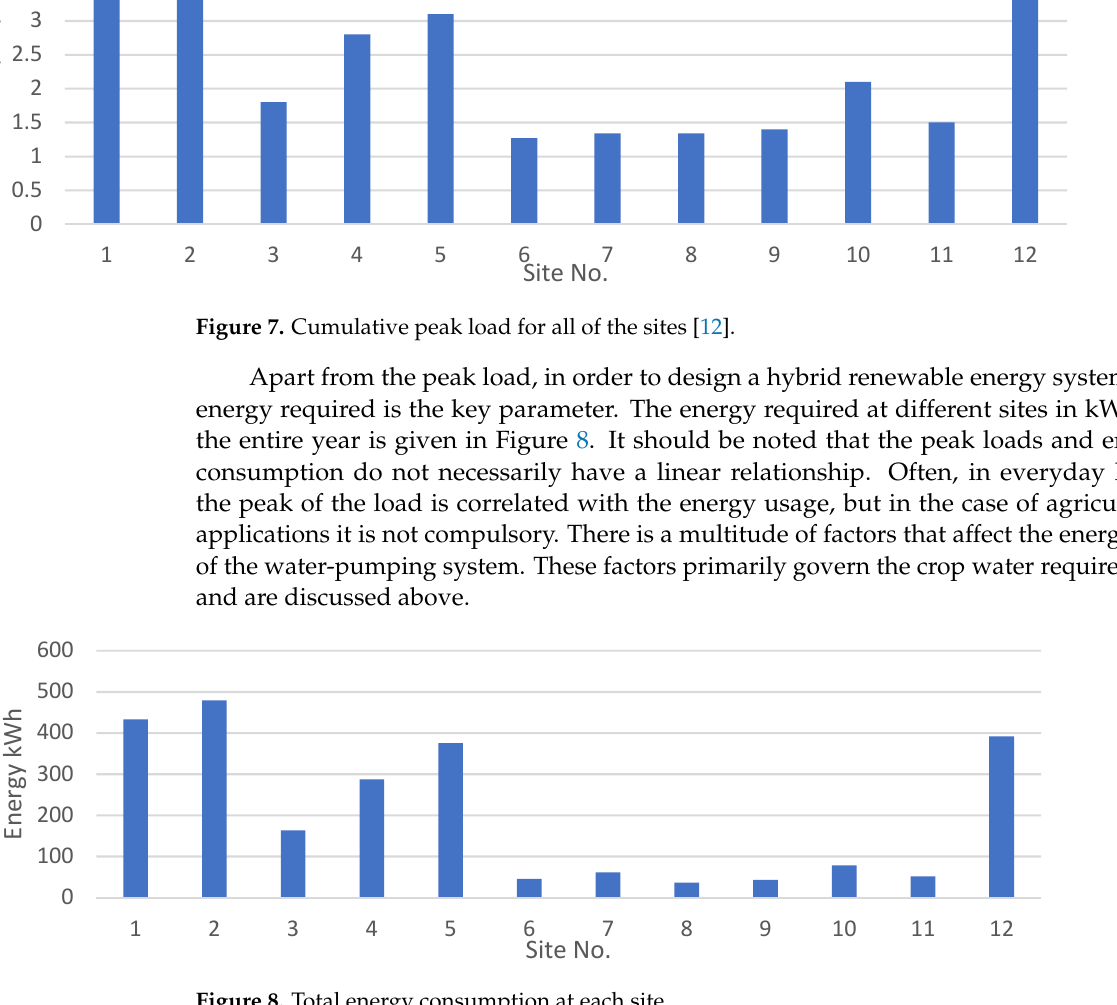
Figure 9. Monthly energy consumption at each site throughout the year. The energy required is spread across the entire day, and thus the calculation consid- ers the maximum load based on the assumption that the pump can run any time. Spread- ing the load delivery over 24 h can potentially benefit the system by reducing the renew- able generation size by spreading the load over a longer period of time, and the potential for the hybridization of renewable energy sources is also promoted. It is pertinent to men- tion that the water pump was designed at peak load, which can only be for a few days during the crop season; the rest of the days, the pump might not need to run all day. However, due to the intermittent nature of the wind and solar PV energy, the water- pumping load was taken as a deferable load. As the overall load and energy calculations were performed, each site was analyzed for wind and solar potential. As is evident from the solar and wind maps of Sudan, a high potential of wind and solar energy is present is Sudan. Figures 10 and 11 show the solar and wind generation potential at each site, as solar irradiance and wind speed. The vari- ation in the wind speed is significant, and during high load periods the wind speed is low, except for sites 11 and 12. Because September is a developing stage of the cotton crop, the energy demand is high, as more water is needed at this stage. The reduction of the wind speed can potentially result in wind being less favorable compared to solar PV, which is not as volatile as wind.